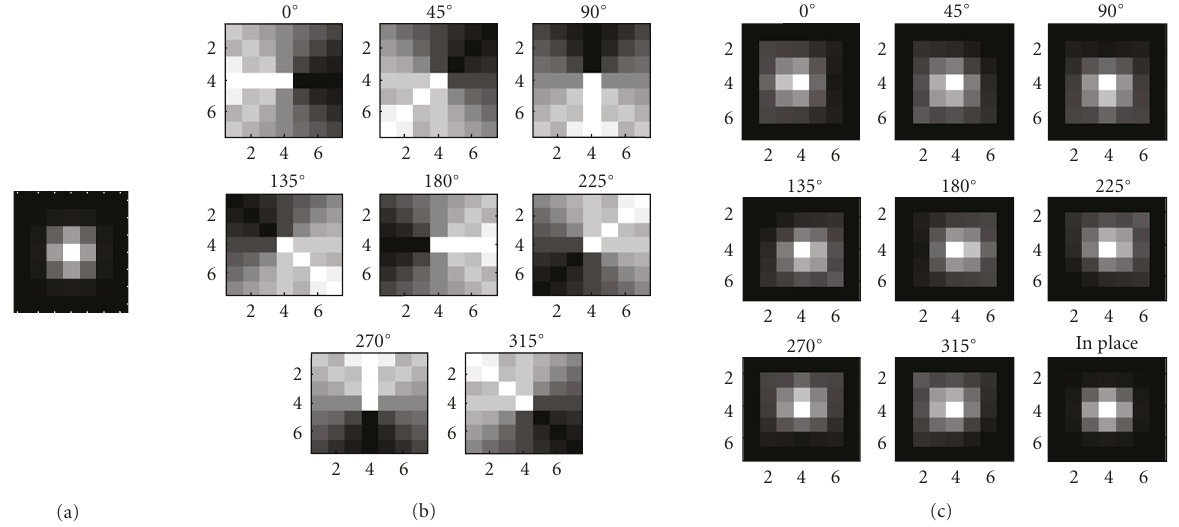
Figure 3: Probability matrices for the various directions. (a) The 7 × 7 W basic matrix, (b) the eight 7 × 7 W Penalty matrices for the di ff erent directions, after using W frame , and (c) the nine W (direction) matrices for p set to 0.5, and velocity range [0-1][ppf].